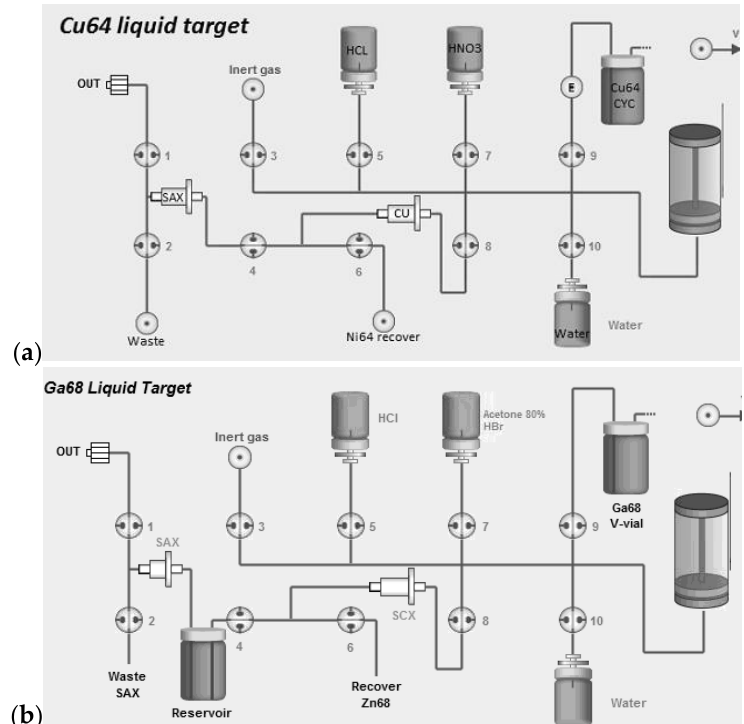
Figure 2. Schematic diagram of IBA Synthera ® Extension synthesizer software to purify and prepare 64 Cu/ 61 Cu-chloride solution ( a ) and to purify and prepare 68 Ga-chloride solution ( b ). Conversely, for the production of copper radioisotopes ( 61 Cu and 64 Cu) the irradiated nat Zn or 64 Ni liquid target solution is dissolved multiple times in water to bring the pH to a suitable range for the adsorption of the copper ions onto a highly selective Cu resin (TrisKem International, Bruz, France) loaded on 2 mL cartridge, as described by Dirks [25]. The pH adjusted solution is then